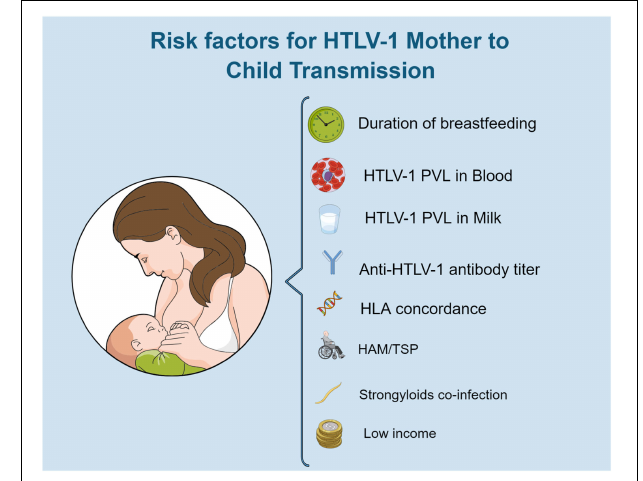
HAM/TSP or strongyloidiasis are the same women who transmit the infection to their children (Gotuzzo et al., 2007). Breast Milk Cells and